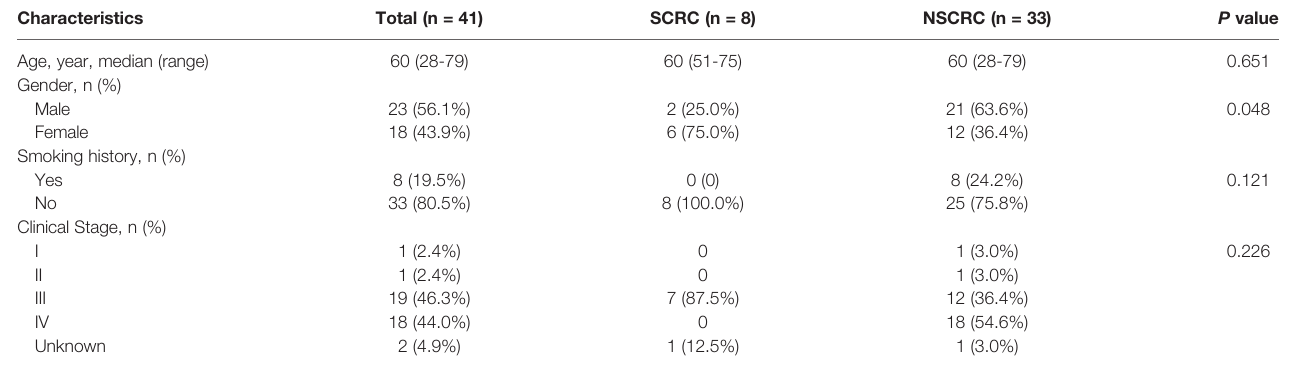
TABLE 1 | Clinical characteristics of SCRC and NSCRC patients.